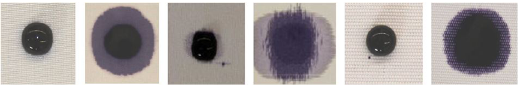
Figure 2. Dye solution drop adsorption on the polyamide fabrics before and after plasma treatment, initial time (t0).